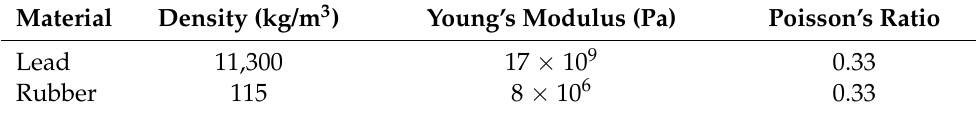
Figure 1. ( a ) Three-dimensional view of a primitive cell based on the hexagonal lattice. ( b ) Structural model of the locally resonant metamaterial. ( c ) Irreducible Brillouin zone. ( d ) Top view of the primitive cell. ( e ) Cutaway view of the primitive cell. Table 1. The corresponding material parameters of the thin plate